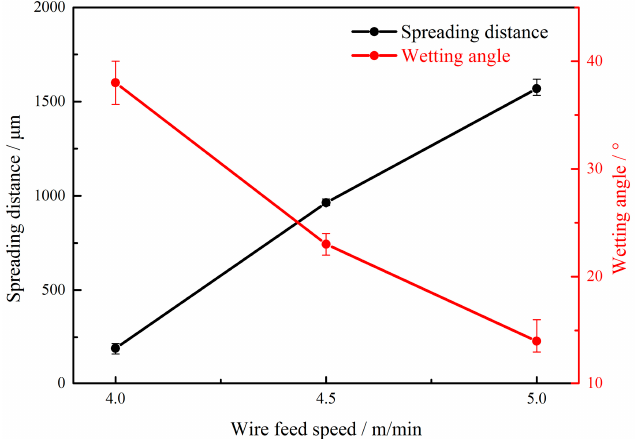
Figure 4. Spreading distance and wetting angle with different wire feeding speeds.